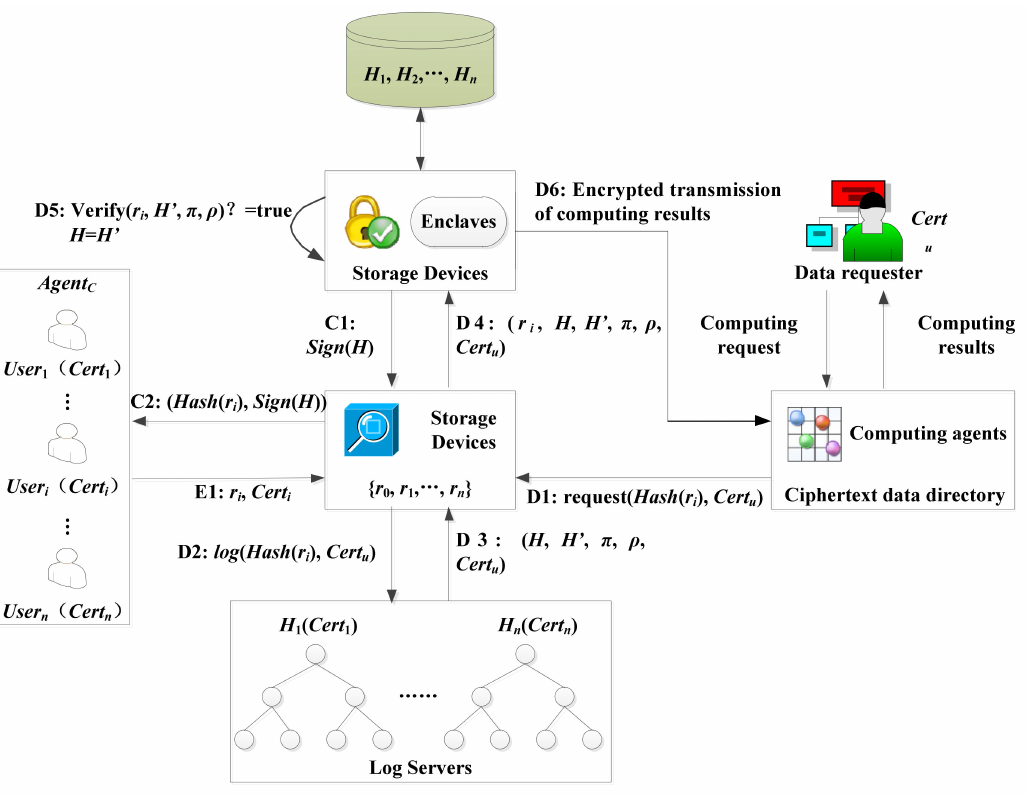
Figure 3. The movement trajectory traceability protocol based on a Merkle tree.